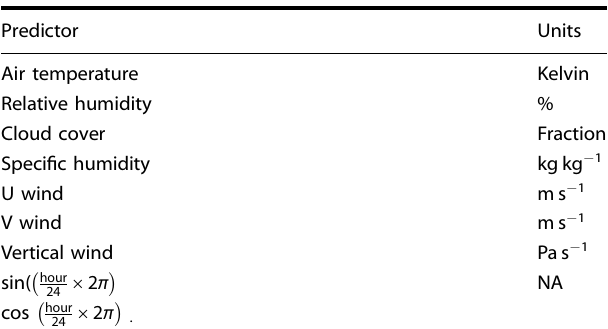
Table 1. Predictor variables used in the machine learning